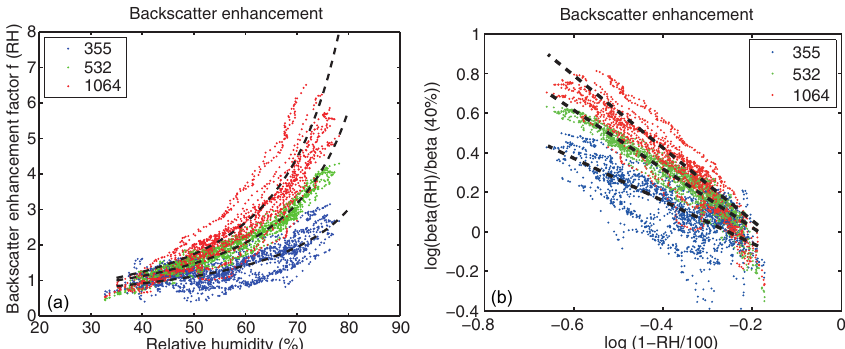
Figure 14. Backscatter enhancement factor for a dry value at 40% RH (a) on a linear scale and (b) on a log–log scale. The three wavelengths are fitted separately by Eq. (2). Table 2. The fit parameters for the backscatter enhancement factor according to Eq. (2). The backscatter enhancement factor f β (80%) calculated with these fit parameters is compared to the measured factor f β (75–80%) between 75 and 80% RH. The extinction enhancement factor f α (75–80% RH) was derived by Eq. (3) to compare with the literature. Fit